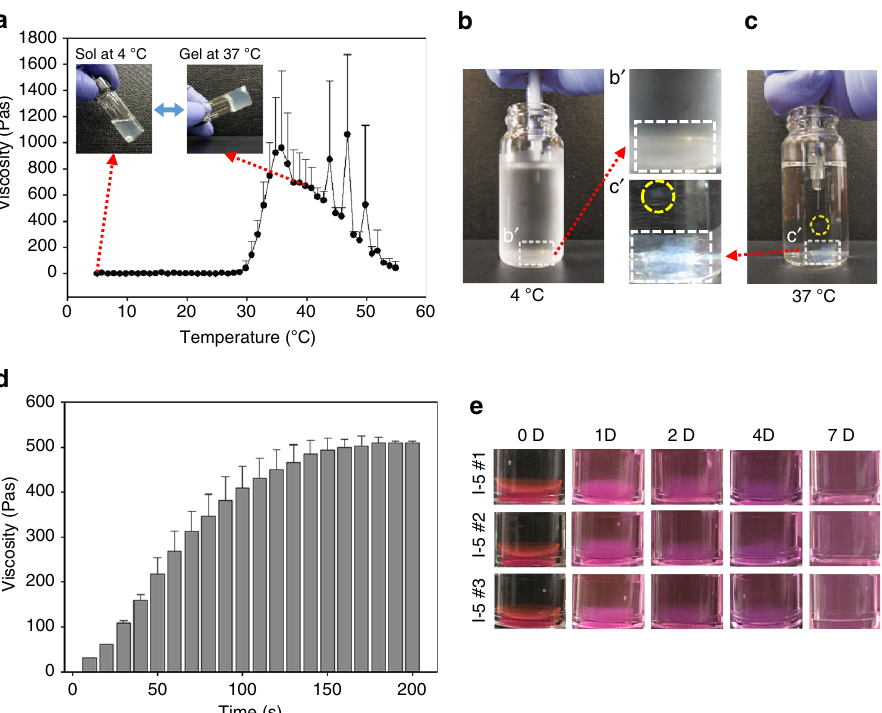
Fig. 2 Sol – gel transition properties and in vitro stability test of I-5 hydrogel. a Temperature-dependent sol – gel transition and changes in viscosity measured by a viscometer. Each black dot represents the average value from four replicated measurements. Error bars represent standard deviation. b , c Visualization of the rapid gelation process. I-5 polymer solution was injected into a glass vial containing distilled water at either 4 °C ( b ) or 37 °C ( c ). After being injected into the water at 37 °C, the polymer solution rapidly turned into a rod-like gel material ( yellow dotted circle ). Gel-like materials accumulated at the bottom of the vial ( white dotted rectangle , c ). In comparison, there was no visible opaque gel-like material in the vial containing water at 4 °C ( white dotted rectangle , c ). Images in the white dotted rectangles in b , c were magni fi ed in b ʹ , c ʹ . d Changes in viscosity as a function of time elapsed after the temperature is set as 37 °C. Each bar is the average of three replicate measurements. Error bars represent standard deviation. e In vitro stability test. Three independent I-5 gels were monitored until 7 days in vitro at 37